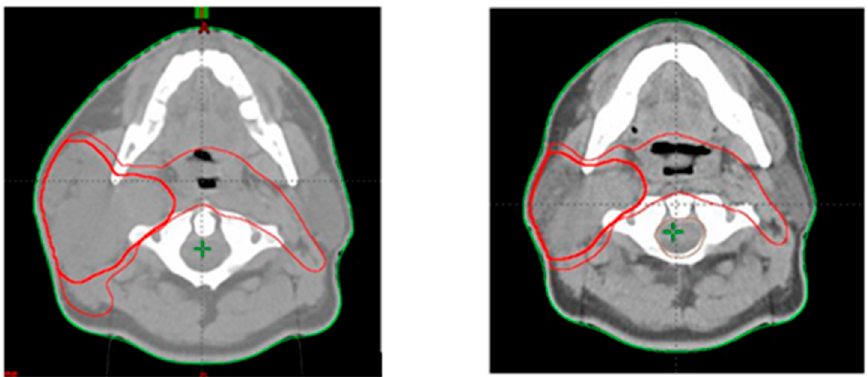
Figure 1. Tumor volumes contoured at first CT scan ( left ) and second CT scan after completion of 21 radiotherapy fractions ( right ).